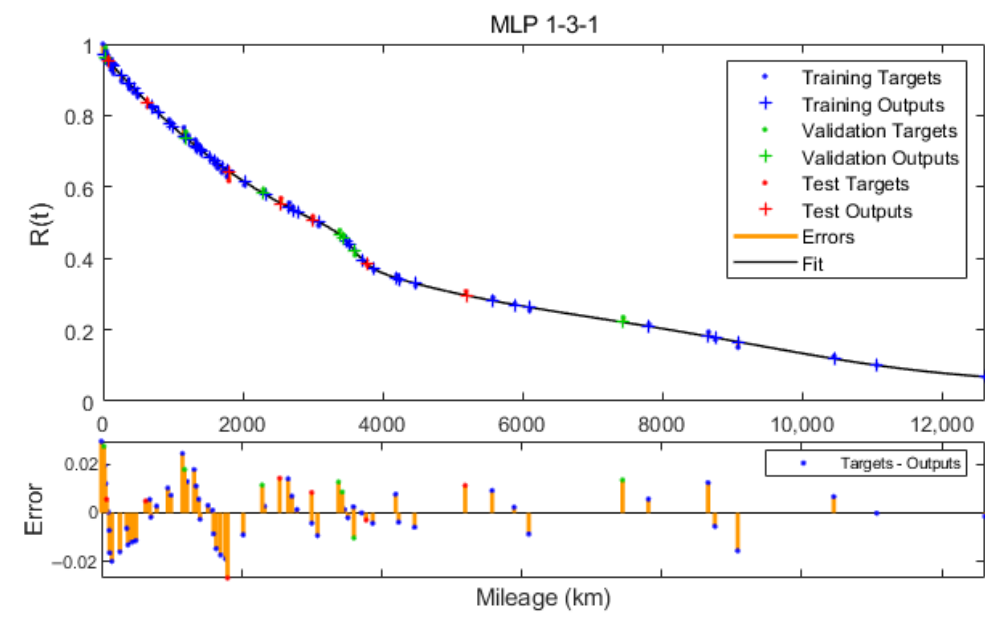
Figure A2. Reliability function approximated by MLP 1-3-1.